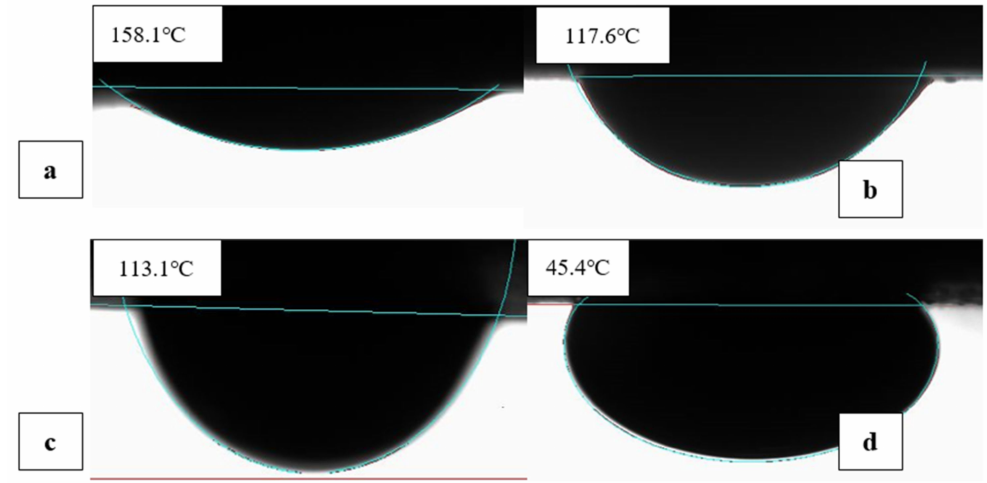
Figure 17. Effect of EW-NF on pellet treatment at reduced temperature: ( a ) The initial oil-wet state; ( b ) after soaking in 4dsw2Mg2S for 72 h; ( c ) after soaking in 4dsw2Mg2S-NP for 48 h; and ( d ) after soaking in 4dsw2Mg2S-NP for an additional week.